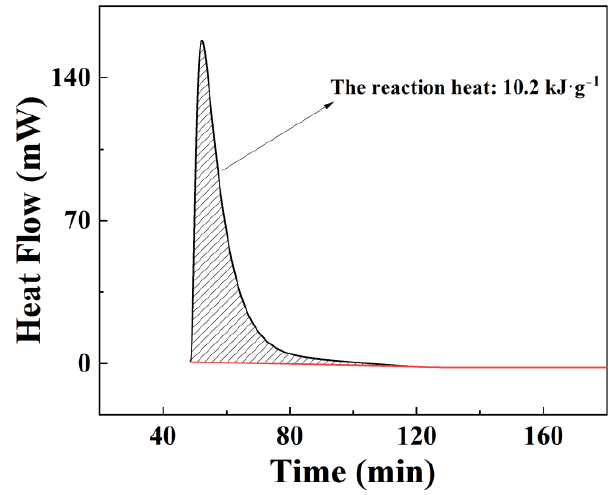
Figure 5. Reaction heat of Al-15 wt% BiOI with water.